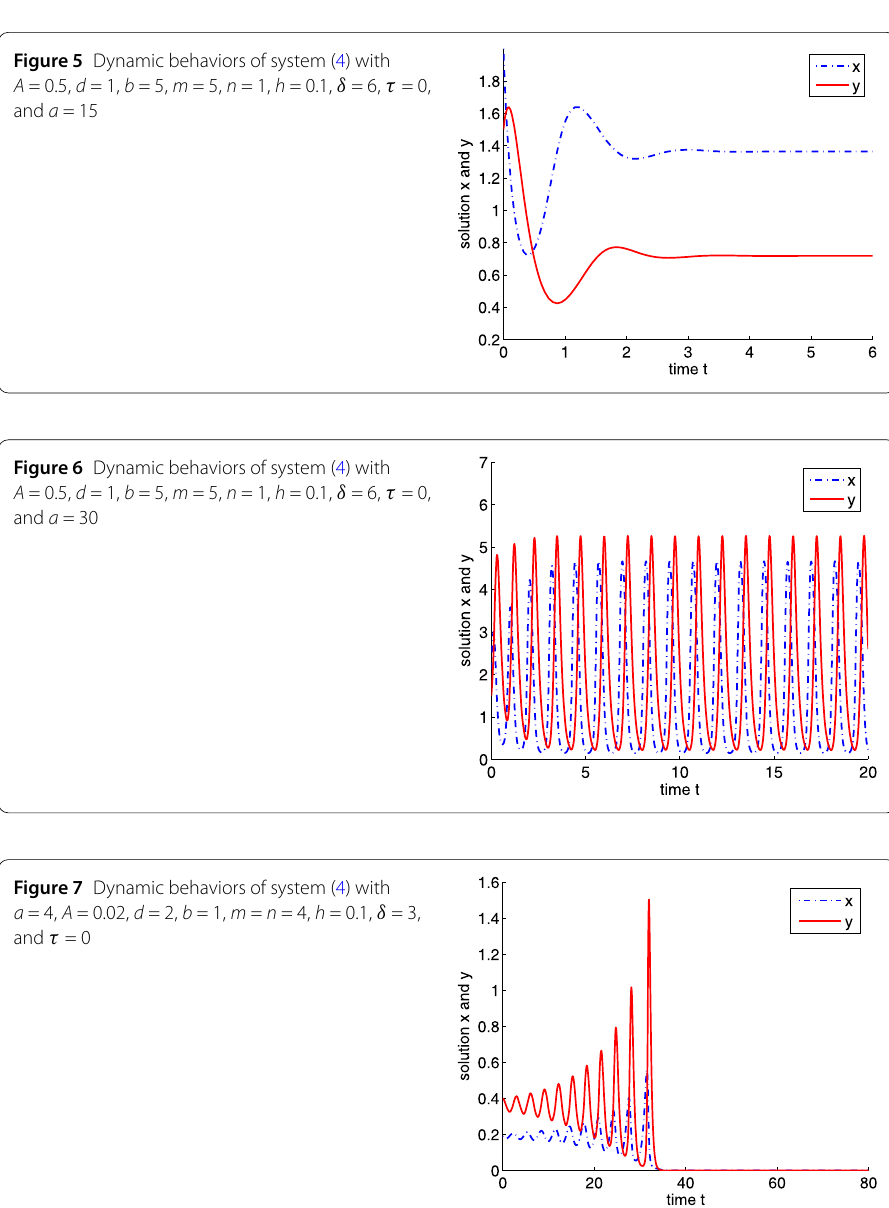
Figure 7 Dynamic behaviors of system (4) with a = 4, A = 0.02, d = 2, b = 1, m = n = 4, h = 0.1, δ =